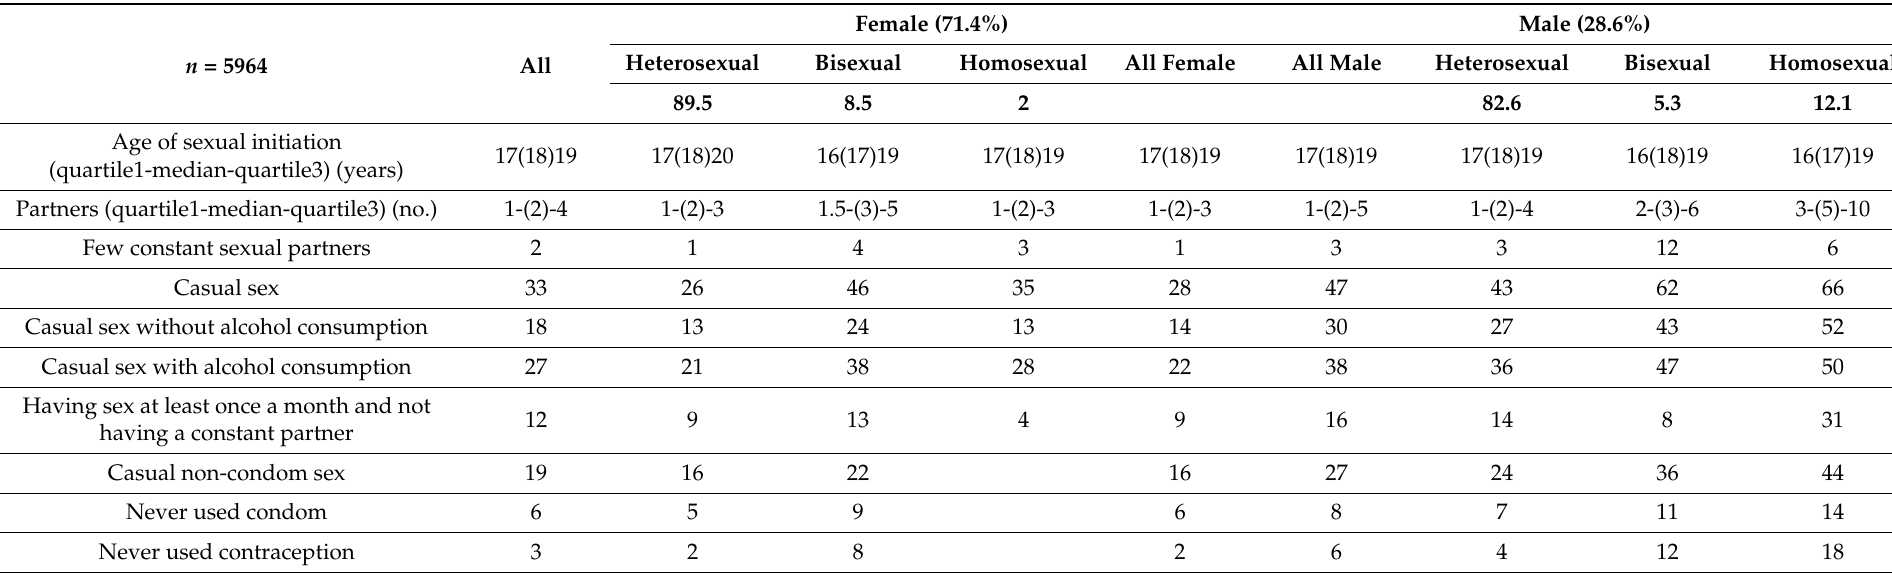
Table 4. Risky sexual behavior among sexually active students. All data contained in the table are presented as a